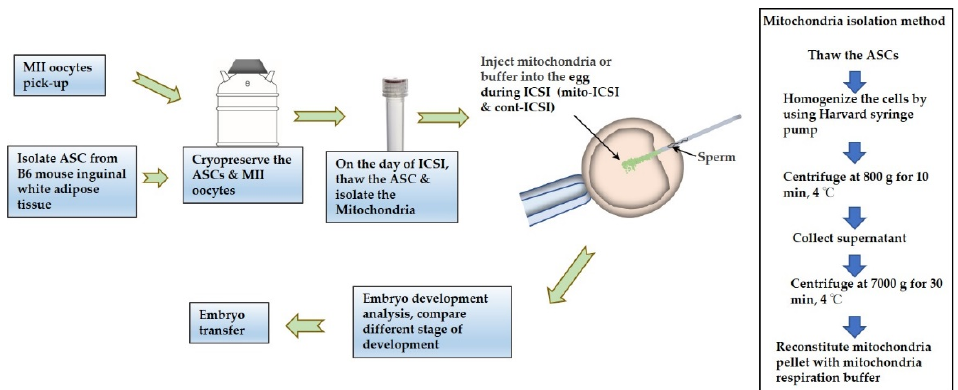
Figure 1. Schematic workflow of the study including the isolation of ASC, isolation of mitochondria, supplementation to oocytes, and analysis of effectiveness.